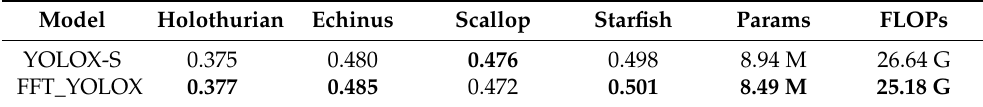
Table 2. Each class AP (0.5 − 0.95) comparisons on URPC dataset with YOLOX-S and